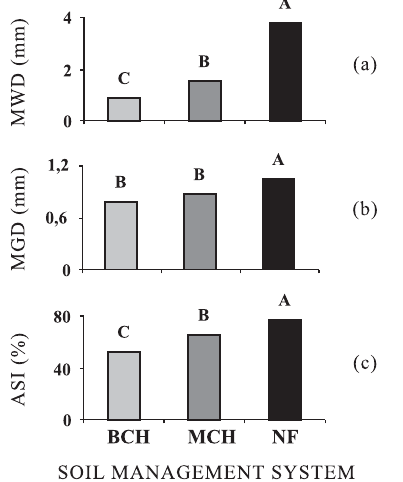
Figure 2. Mean Weighted Diameter - MWD (a), Mean Geometric Diameter - MGD (b) and Aggregate Stability Index - ASI (c) in the 0–0.20 m layer of a Rhodic Haplusdox, under burnt cane harvesting (BCH) and mechanized cane harvesting (MCH), and native forest (NF). Averages with different letters indicate significant differences in the Tukey test at 5 Table 3. Aggregate particle size distribution in the 0–0.20 m layer of a Rhodic Haplustox under burnt cane harvesting (BCH) mechanized cane harvesting (MCH), and native forest (NF)